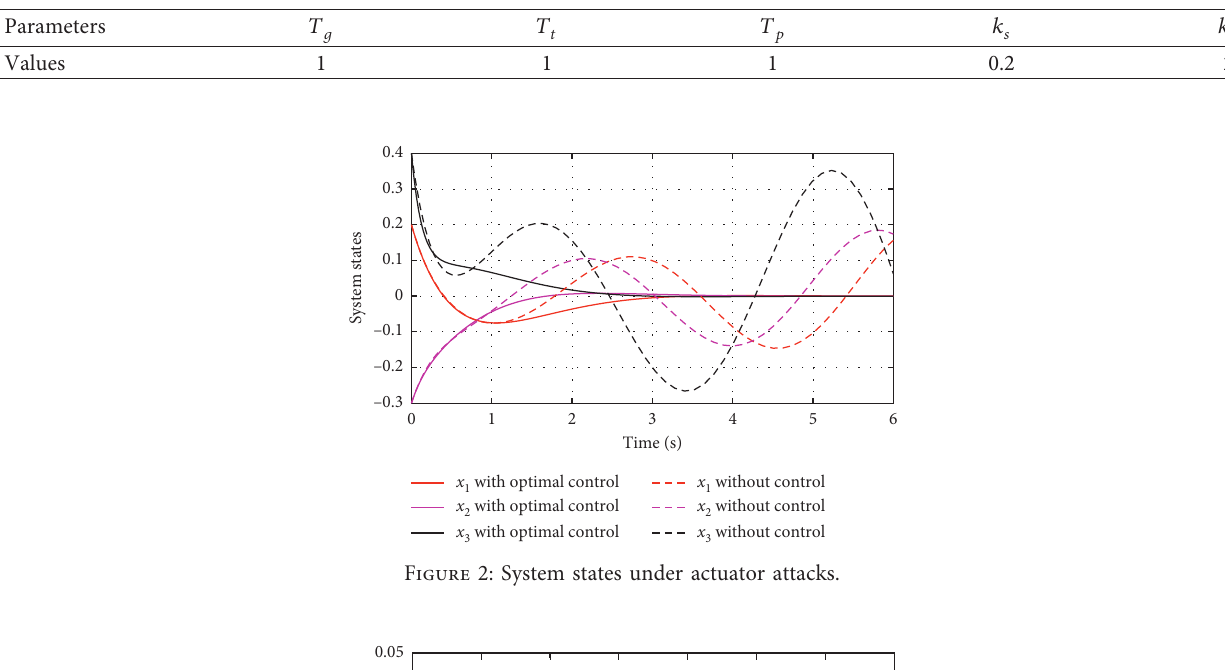
Table 1: Values of system parameters.